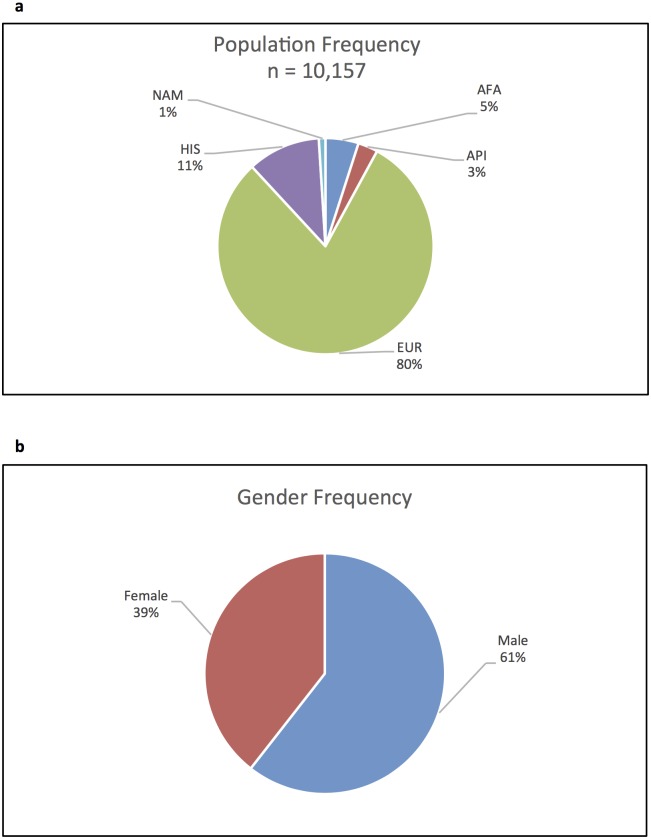
Population demographics.Cohort frequencies are depicted by population a) and gender b).